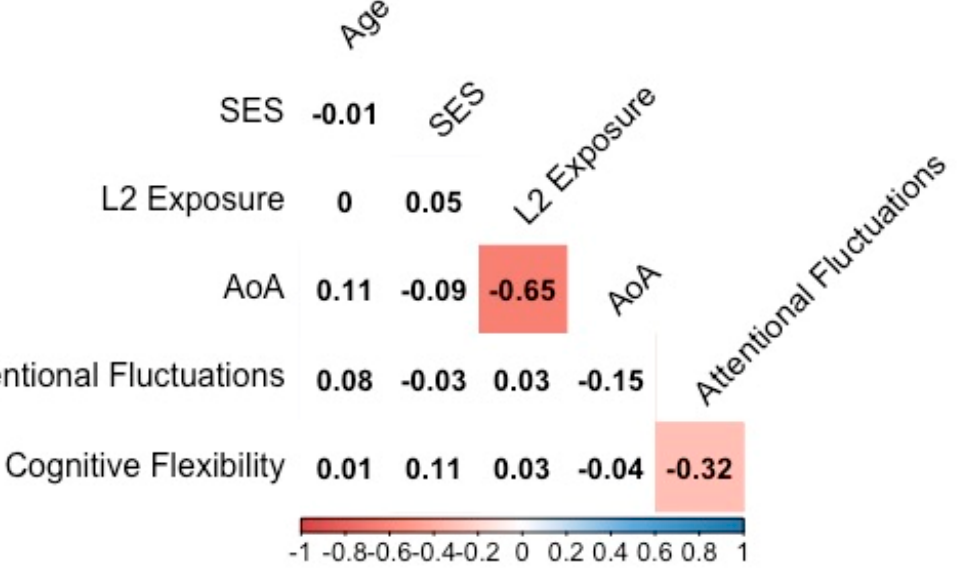
Figure 2. Bivariate correlations between age, SES, years of second language (L2) exposure, age of acquisition (AoA), attentional fluctuations, and cognitive flexibility. Correlation coefficients are displayed, with directionality and strength of each relationship coded in the bottom color bar. All significant correlations are colored.